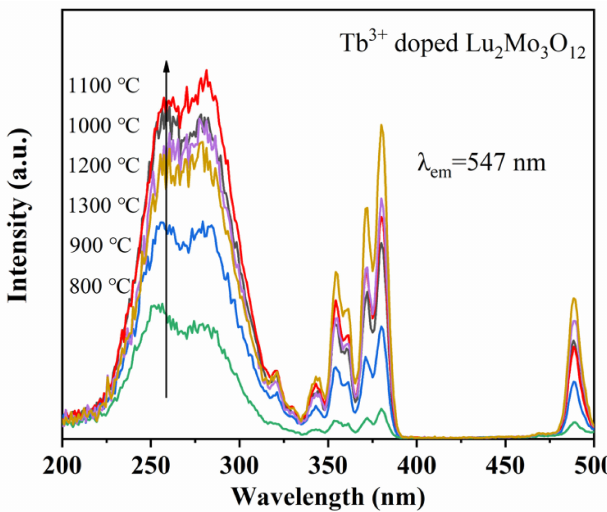
Figure 7. Preparationoftemperature-dependentPLexcitationspectraofTb 3+ -dopedLu 2 Mo 3 O 12